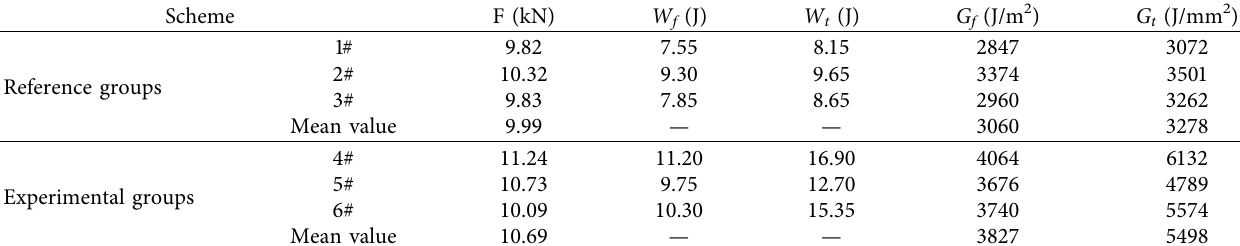
Figure 10: Load-displacement typical curve of the SCB test. Table 9: Low-temperature fracture energy of different